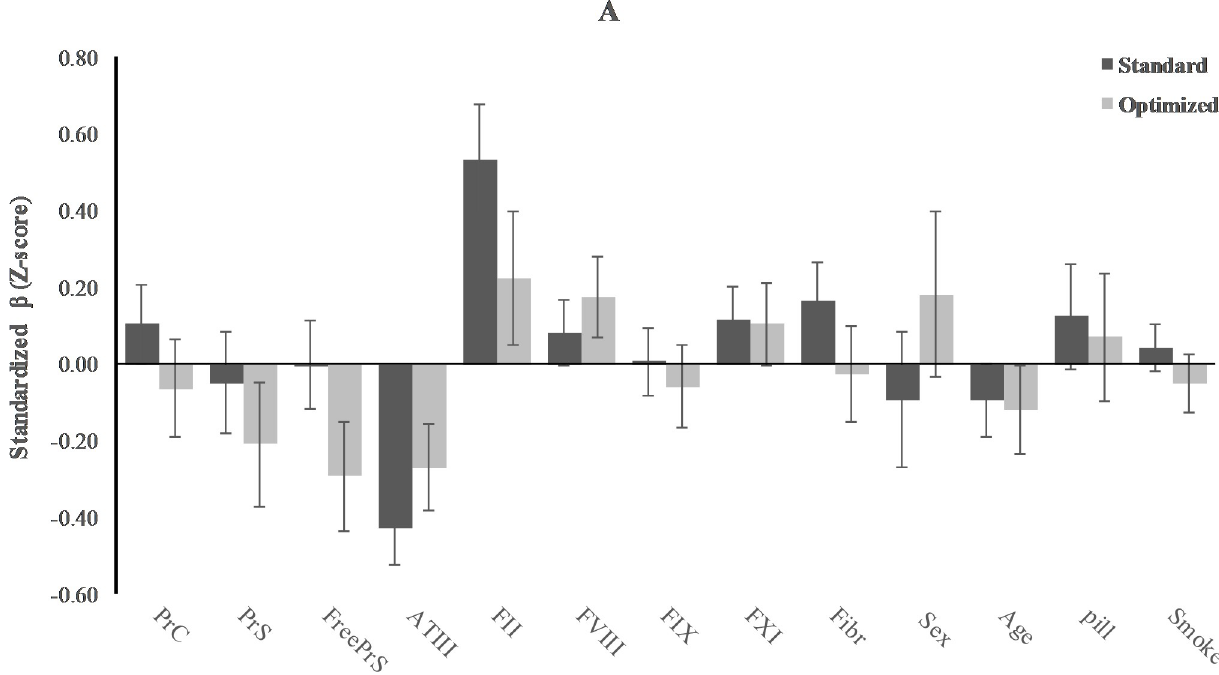
Fig 4. Effect of CTI on relative contribution of coagulation factors to thrombin generation measured with CAT. Mean change in thrombin generation with 1 standard deviation (SD) increase in coagulation determinants, while other determinants remain the same. Results for standard versus optimized